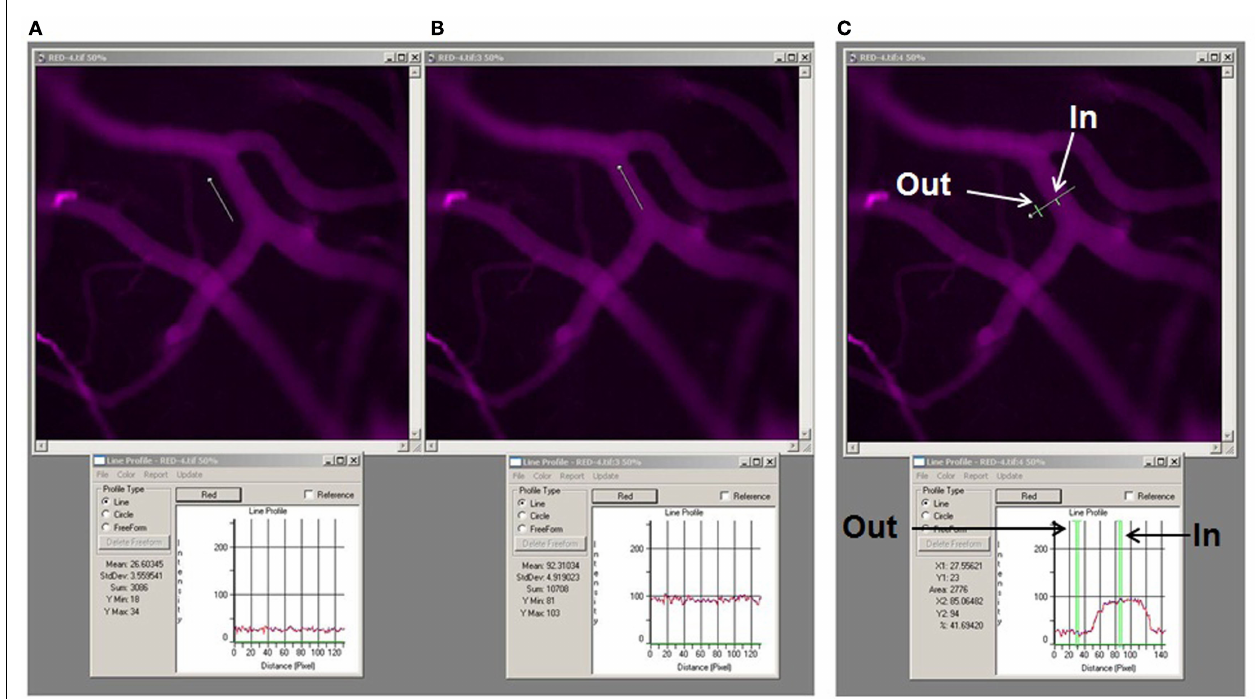
mean fluorescence intensity inside the venule is 92.3 fluorescence intensity units (FIU) and in the adjacent interstitium is 26.6 FIU.Thus ratio of fluorescence intensity in interstitium to that in the venule is 0.29.This value was expressed as a percent of baseline values calculated for images obtained immediately after infusion of the dual-tracer probe. Example of the LPP placed across the venular segment and over the adjacent interstitium (upper image) with the fluorescence intensity profile along the LPP (below) is shown (C) . Arrows indicate precise locations of where the fluorescence intensities were measured along the LPP. Note that fluorescence intensity inside the venule (In) is 85.1 FIU and in interstitium (Out) is 23.Thus ratio of fluorescence intensity in interstitium to that in the venule in the marked places along the LPP is 0.27. However, to obtain reliable data the LPP should be moved along the vessel and several measurements performed to calculate an average of these results. Since the same data, with better precision, can be obtained using the method described above (A,B) , we placed the LPP across the vessel to define the vascular wall and the distance from the vessel where the LPP should have been placed (parallel to the vessel) in